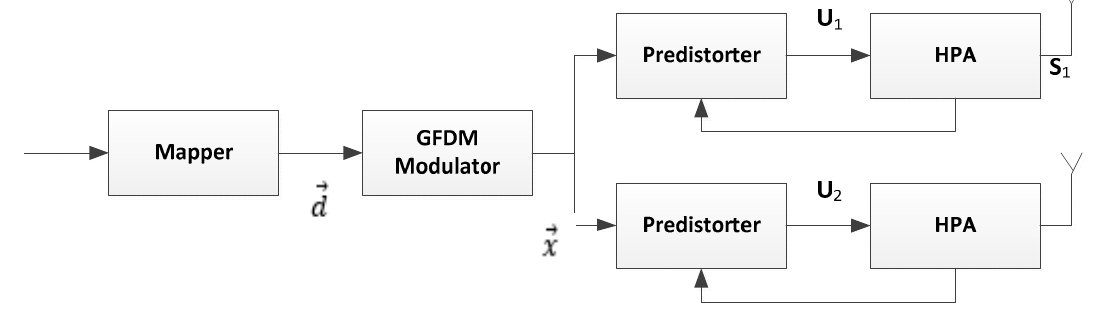
Figure 3. MIMO-GFDM system with predistorter.